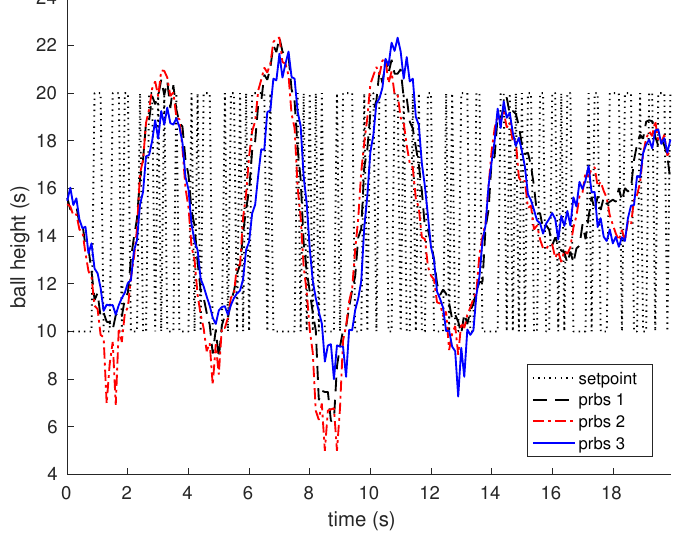
Figure A3. An excerpt of the response to a PRBS (Pseudo Random Binary Signal) input of amplitude 10 cm applied to the